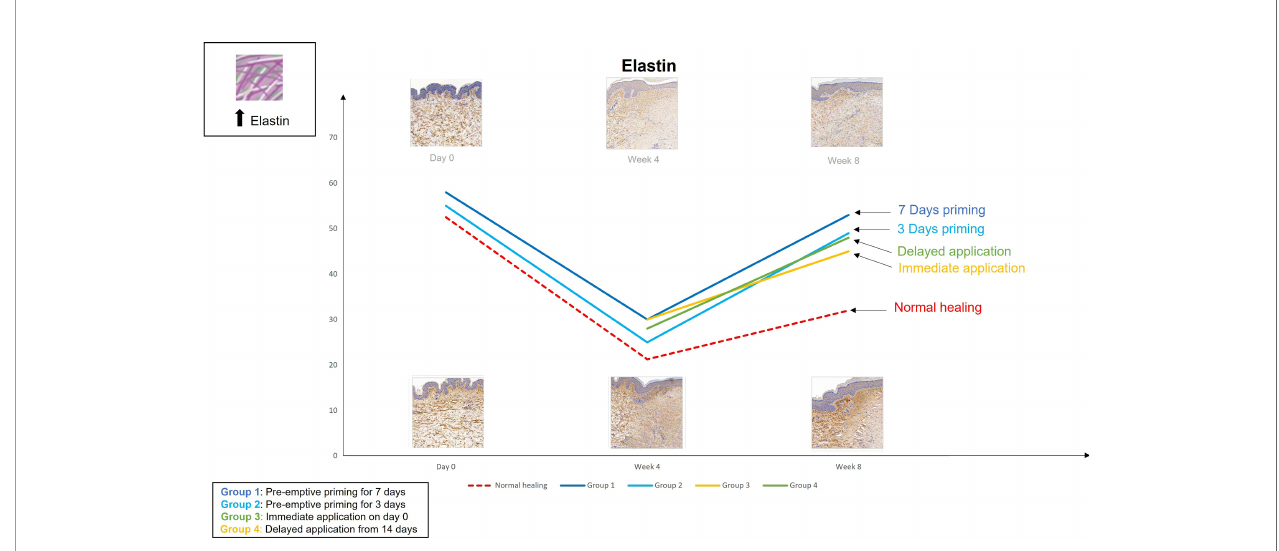
FIGURE 5 | We evaluated the pre-emptive, immediate and delayed intervention of topical Epigallocatechin-3-gallate on skin scarring by conducting a randomsied double blind controlled trial on 40 healthy volunteers over 8 weeks. Graphical representation of the trends for elastin which demonstrates that pre-emptively priming the skin 7 days prior to injury shows greater increases in elastin compared to all other modes of application.